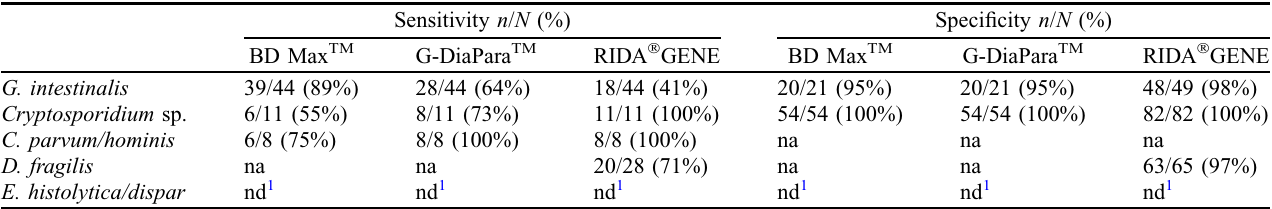
Table 2. Performances of the multiplex PCR assays compared to microscopy on 93 positive samples analysed routinely na: not applicable; nd: not determined.